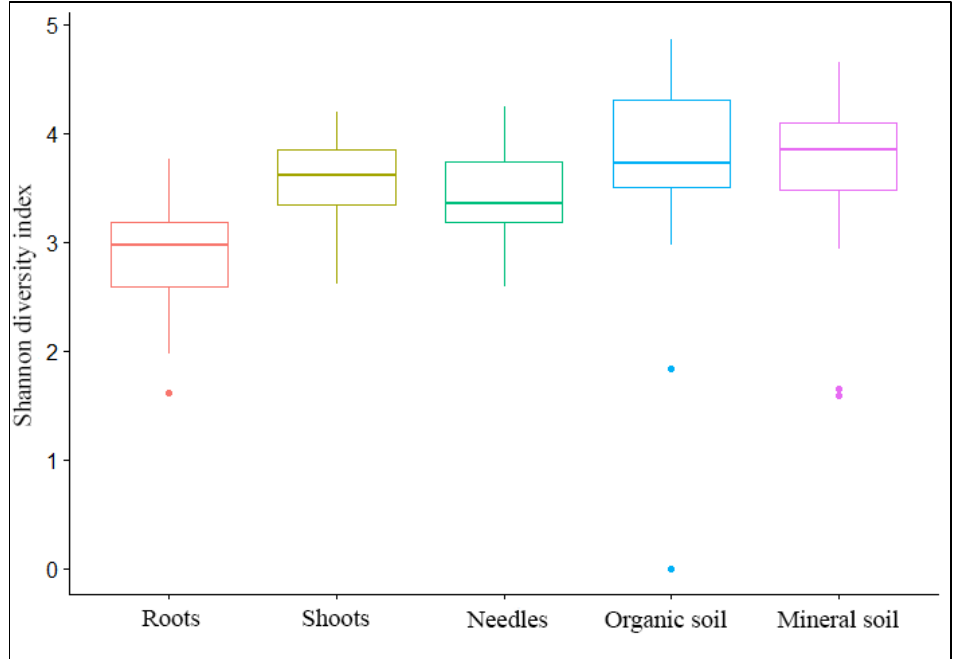
Figure 2. Differences in the Shannon diversity index of fungal OTUs among different substrates. In the Mann – Whitney test, p -values were: roots vs. shoots p < 0.05, roots vs. needles p < 0.05, roots vs. organic soil p < 0.05, root vs. mineral soil p < 0.05, shoot vs. needles p = 0.97, shoots vs. organic soil p = 0.06, shoots vs. mineral soil p = 0.23, needles vs. organic soil p = 0.06, needles vs. mineral soil p = 0.06, and organic soil vs. mineral soil p = 0.99.